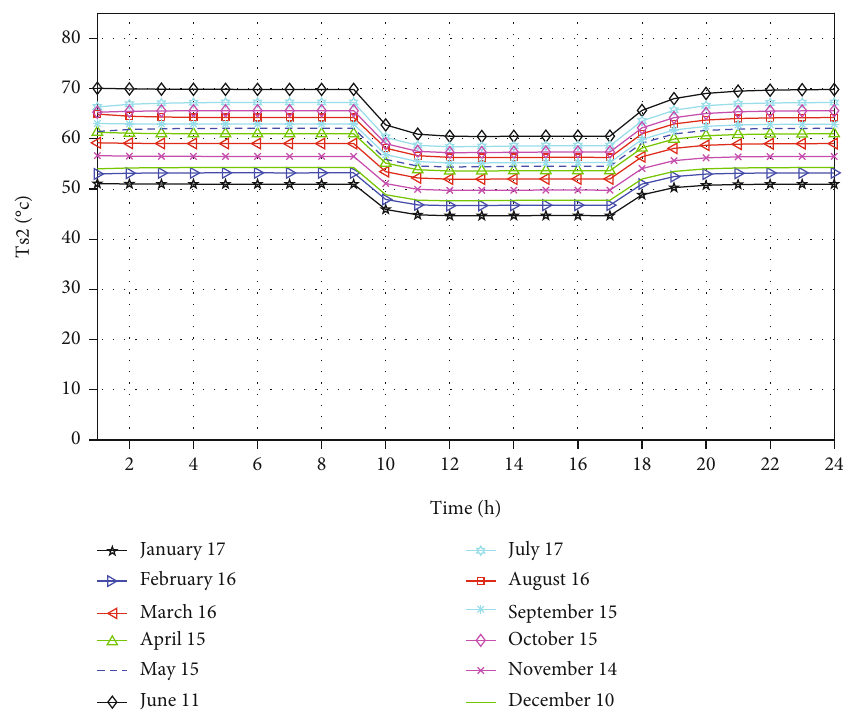
Figure 11: Water temperature for constant power supply energy option in 24 hours using battery storage and 8 hours of hot water consumption at a constant rate.